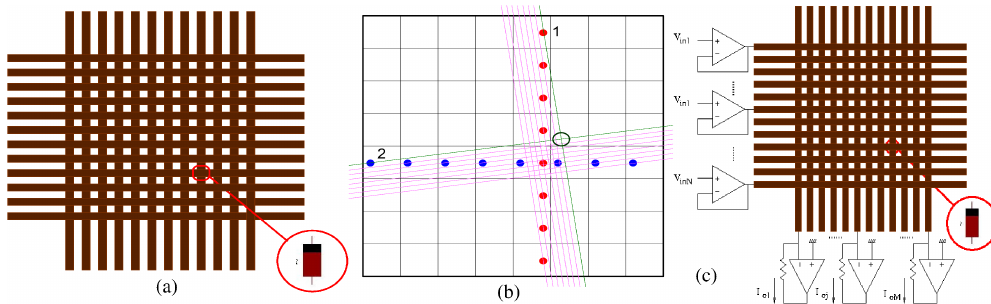
Figure 8. Illustration of the proposed hybrid CMOS/memristive CMOL architecture. ( a ) Memristive devices fabricated in the cross-points of a crossbar array and ( b ) proposed CMOL architecture. ( c ) Neuromorphic architecture composed of CMOS neurons connected to a crossbar array of